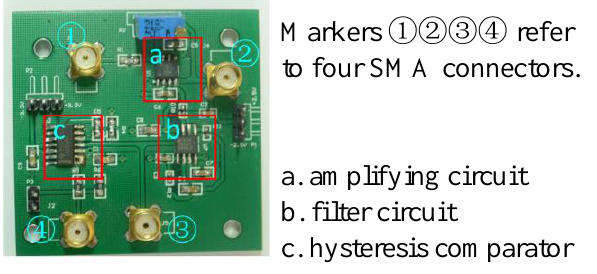
Figure 13. Signal condition unit.